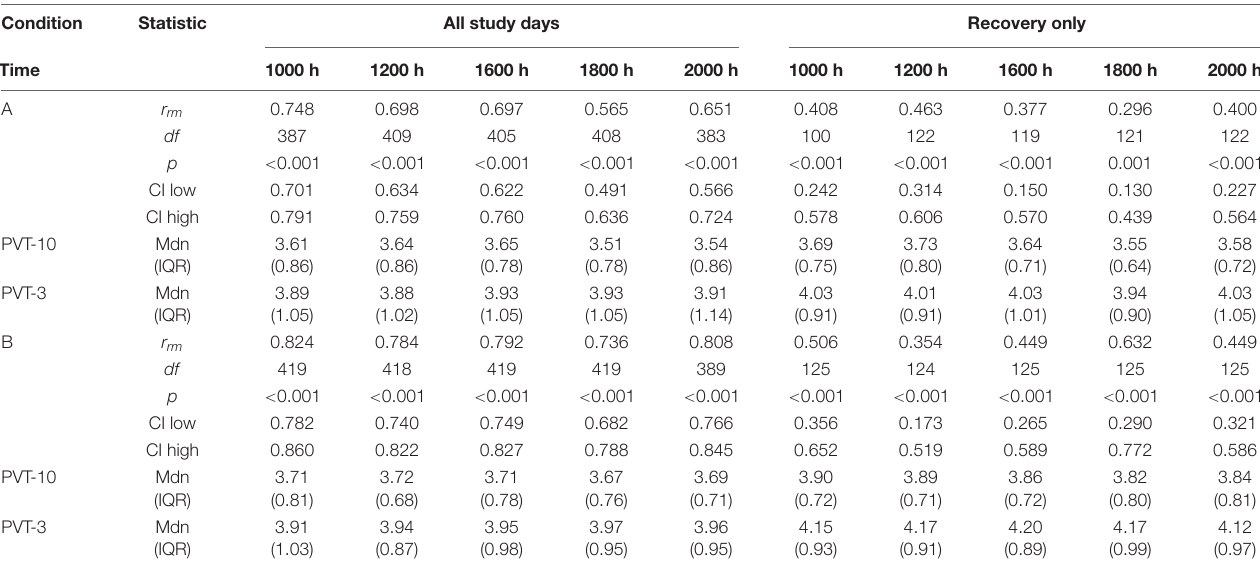
TABLE 4 | PVT-10 and PVT-3 1/RT rmcorr results by time